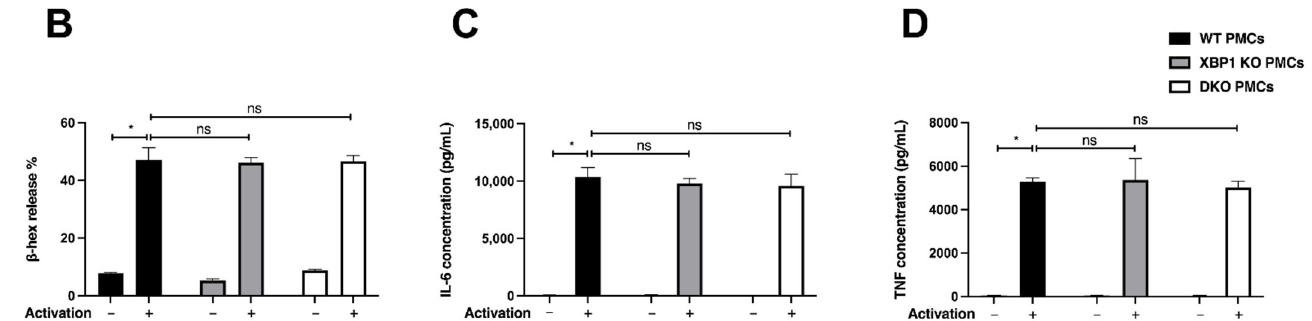
Figure 4. The absence of IRE1 α does not affect PMC secretory response to IgE-mediated activation. ( A ) PMCs expanded from the peritoneal lavage of the WT, XBP1 KO, and DKO strain mice were sorted for YFP expression and visualized by TEM. Typical cells from 2 independent separations are shown. Red arrows show the perinuclear ER, which is not discerned in the DKO PMCs. Bars: 500 nm (upper panel) and 2 µ m (lower panel). ( B ) PMCs were sensitized with mouse IgE-anti-DNP (0.5 µ g/mL, 18 h), followed by activation with DNP-BSA (50 ng/mL, 1 h). Following activation, supernatants and cell pellets underwent a chromogenic assay for β -hex quantification. Data are shown as the mean ± SD of three independent experiments. Supernatants were analyzed for secreted cytokines as a response to IgE-mediated activation of 4 h in YFP-sorted XBP1 KO PMCs and DKO PMCs, as compared to WT PMCs. The amounts of ( C ) IL-6 and ( D ) TNF were determined by ELISA. Each bar represents the average ± SD of three independent experiments. * p < 0.05.